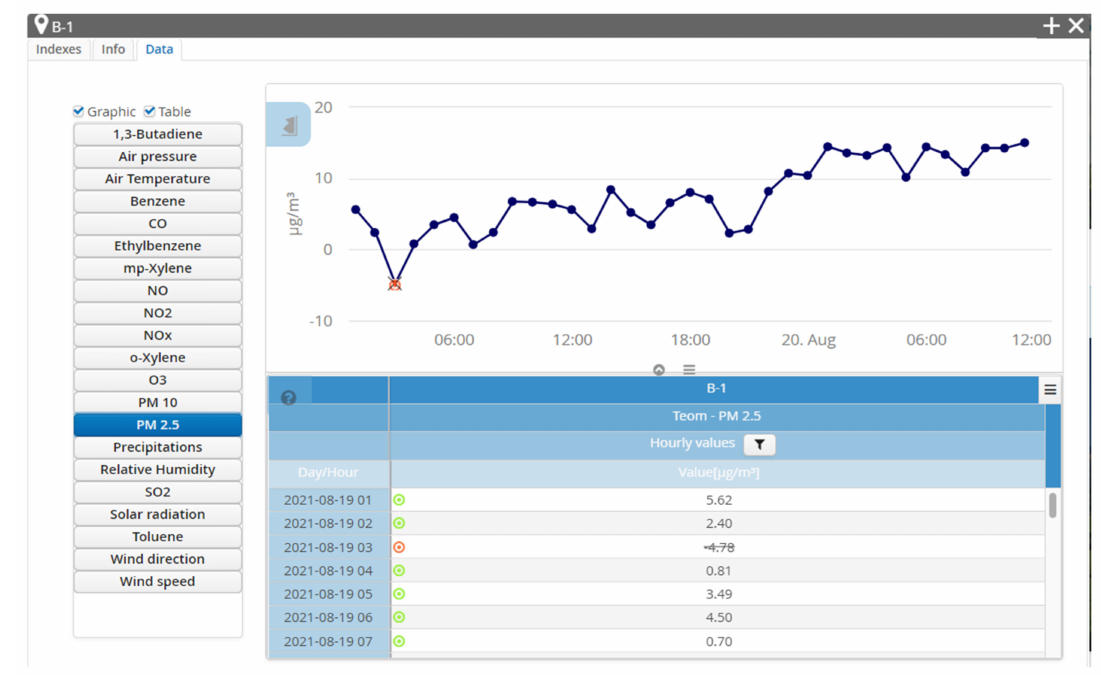
Figure 5. Data collected by station B-1 regarding the PM 2.5 pollutant [3].